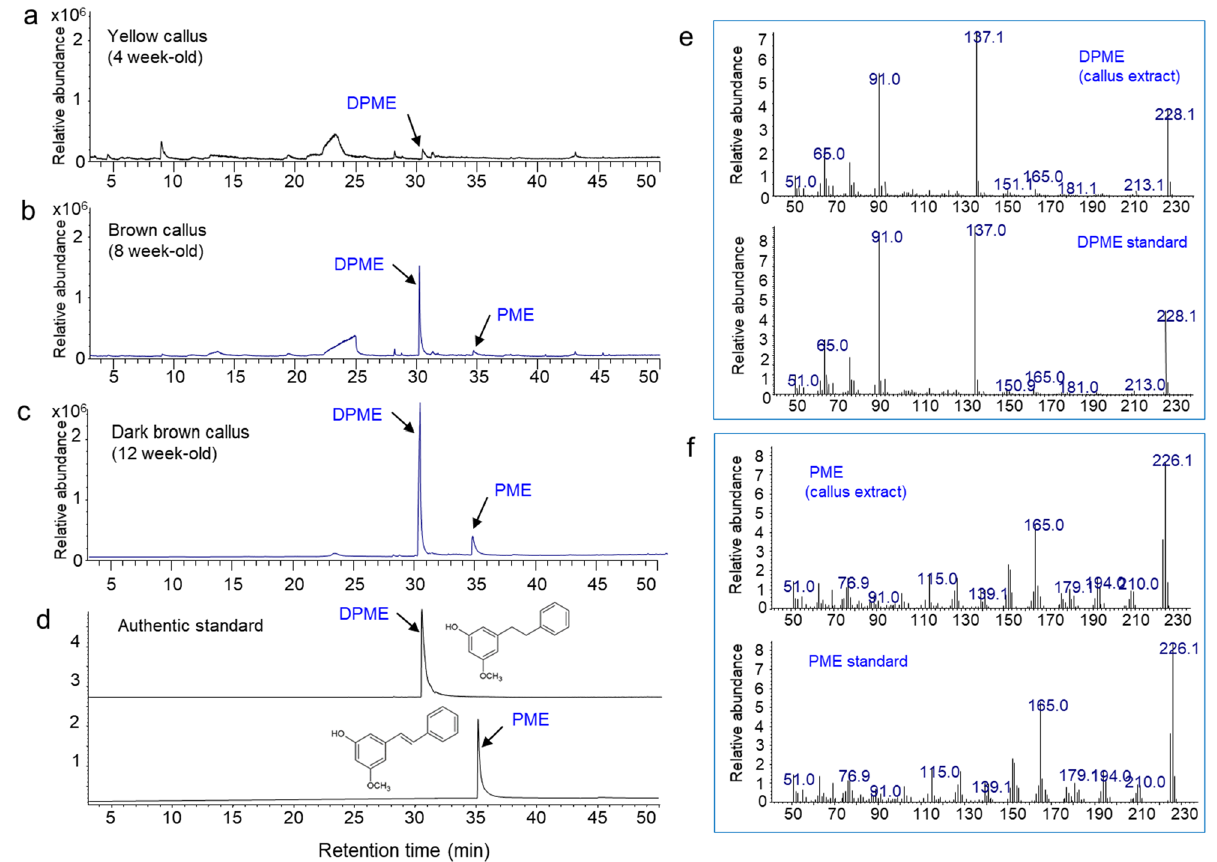
Figure 5. GC/MS analysis of the production of DPME and PME in P. strobus calli by prolonged culture. ( a ) GC chromatogram of extract from yellowish calli after 4 weeks of culture. ( b ) GC chromatogram of callus extract from pale brown callus after 8 weeks of culture. ( c ) GC chromatogram of callus extract from dark brown calli after 12 weeks of culture. ( d ) GC chromatogram of authentic standards of DPME and PME. ( e ) Mass fraction of a DPME peak in callus and DPME standard. ( f ) Mass fraction of a PME peak in callus and PME